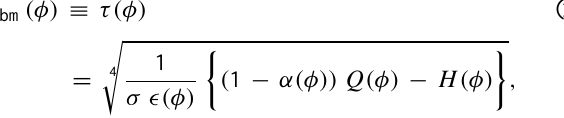
133 ◦ E/50 ◦ S and of 0.02 m at 45 ◦ E/52 ◦ S. As expected in